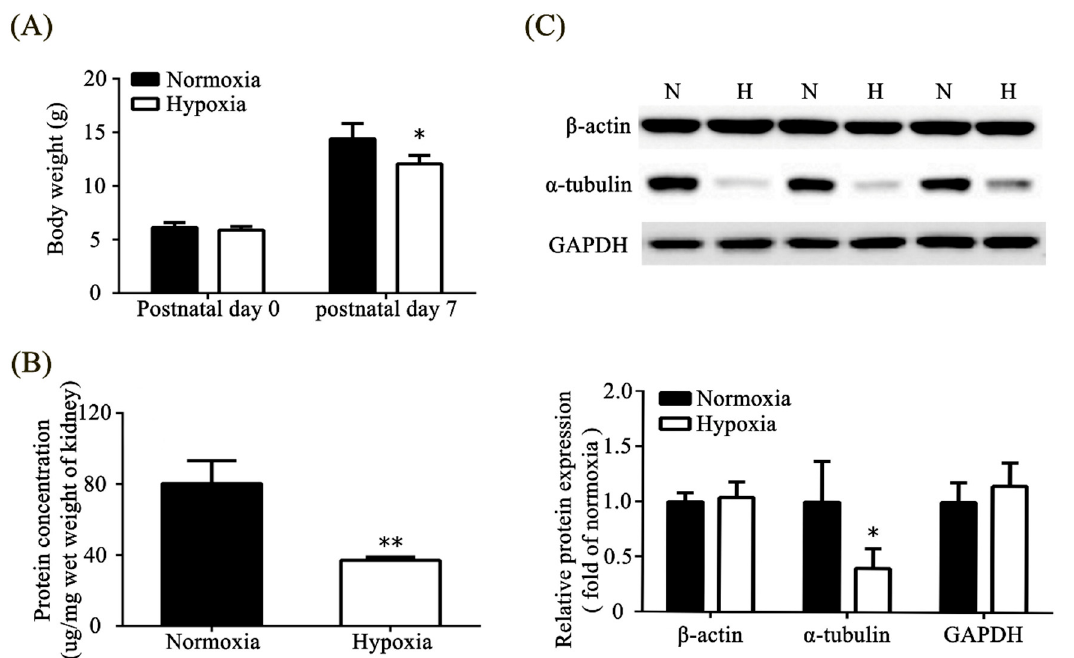
Figure 3. Hypoxia caused growth restriction and protein loss in the kidney. ( A ) Body weight on postnatal days 0 and 7. ( B ) Total protein concentration of the kidney tissue. ( C ) Western blot and quantitative analysis of different housekeeping proteins in the kidney tissue. The values are presented as mean ± standard deviation, * p < 0.05, ** p < 0.01, versus the normoxic group. The p -values were estimated via Mann–Whitney U test ( n = 6–8). N, normoxia; H, hypoxia.